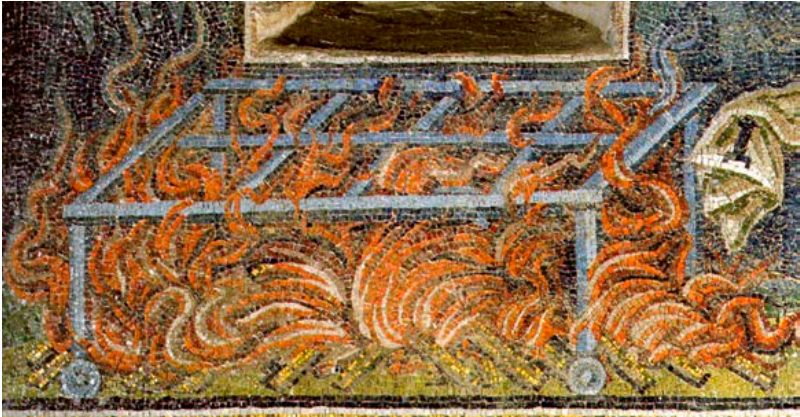
Figure 5. Mausoleum of Galla Placidia, southern lunette detail,